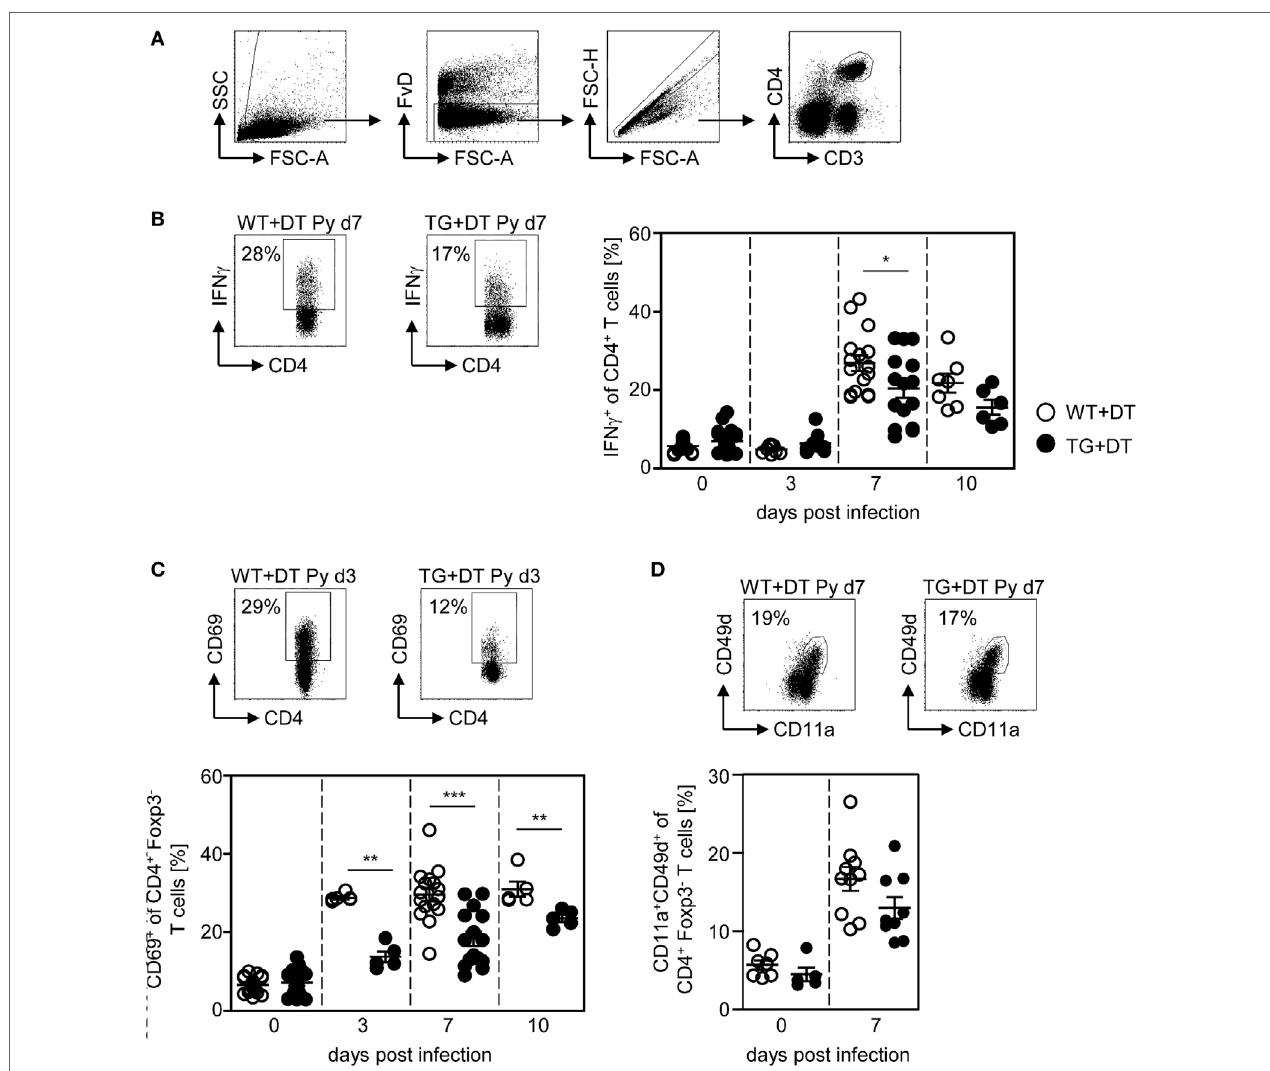
FigUre 3 | Reduced frequencies of activated CD4 + T cells in long-term dendritic cell (DC)-depleted Plasmodium yoelii -infected mice. DT-treated ( + DT) RosaiDTR/ CD11c-cre (TG) and RosaiDTR wild-type (WT) mice were infected with P. yoelii for 3, 7, and 10 days. At indicated time points, splenocytes were isolated and the frequencies of (B) IFN- γ -producing CD4 + T cells as well as (c) CD69-expressing and (D) CD11a + CD49 + -expressing CD4 + Foxp3 − T cells were analyzed by flow cytometry. The gating strategy is depicted in (a) and representative dot plots are shown in the upper panels. Results from two to five independent experiments with n = 5–16 mice per time point (d0; n = 5–25 mice) were summarized as mean ± SEM. Each data point represents one animal. Student’s t -test was used for statistical analysis. ** p < 0.01; *** p <